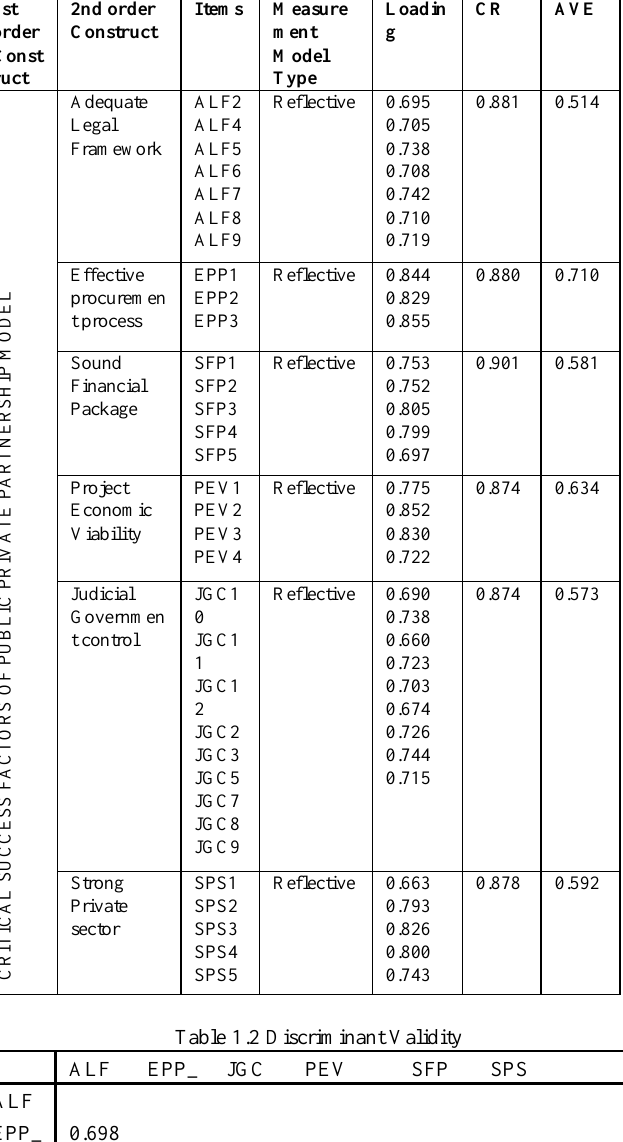
Table 1.1 Composite Reliability and Convergent Validity of Public